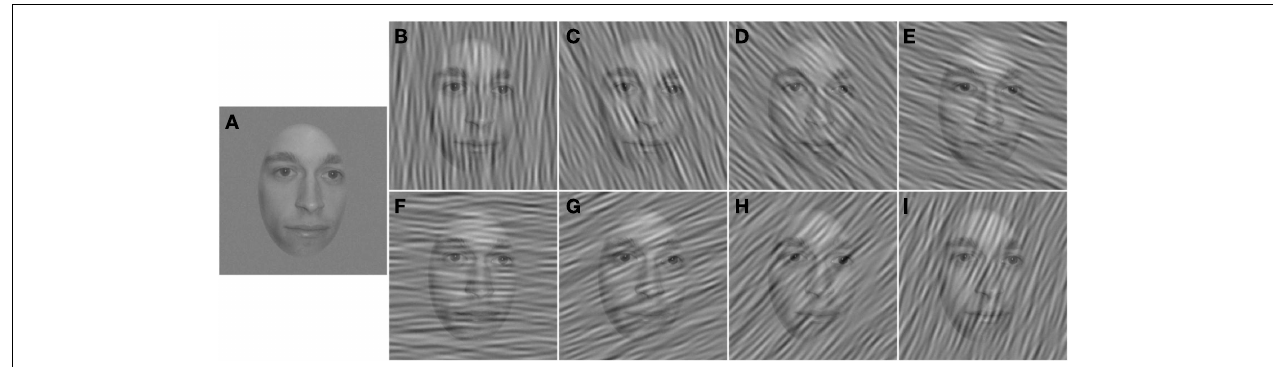
FIGURE 2 | High-contrast examples of stimuli in each condition. (A) White noise only. (B–I) White noise and orientation-filtered noise with center orientations ranging from − 90˚ (B) to 67.5˚ (I) in 22.5˚ steps.